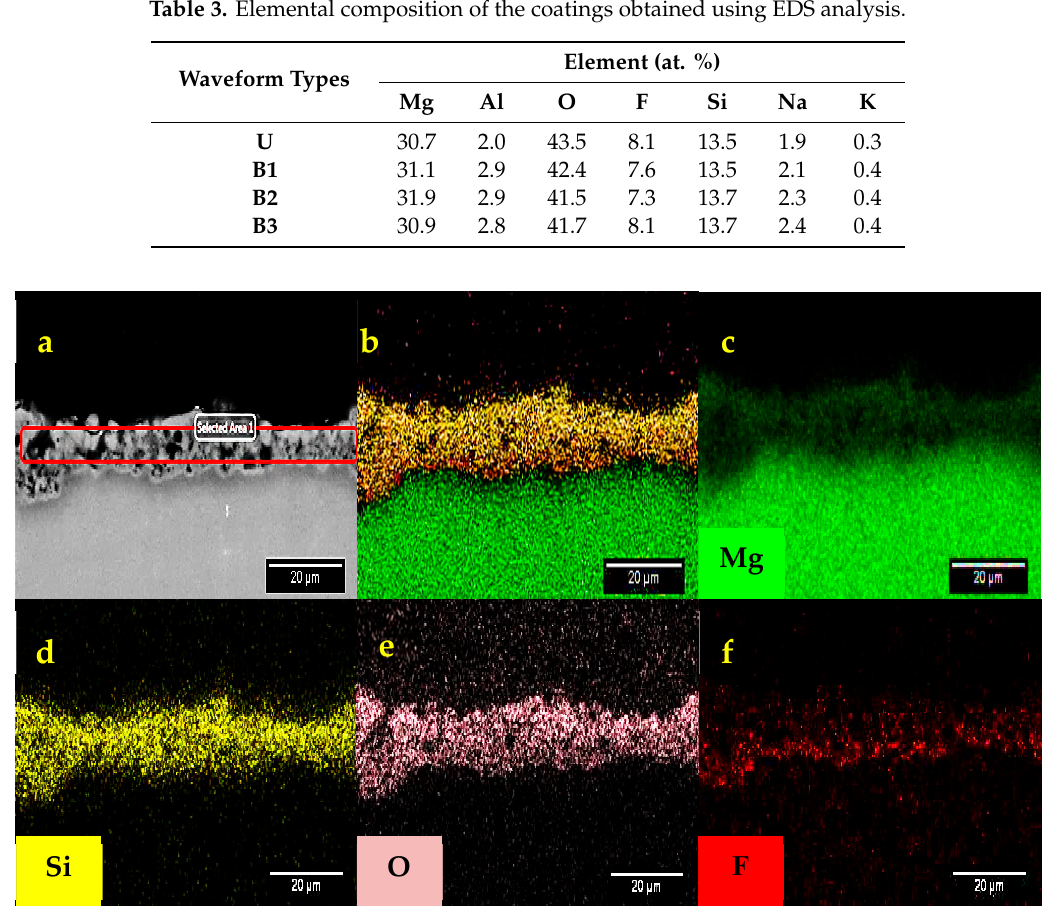
Figure 6. ( a ) Cross-section and elemental maps of U produced coating; ( b ) overall colors map, ( c ) map of magnesium, ( d ) map of silicon, ( e ) map of oxygen and ( f ) map of fluoride.